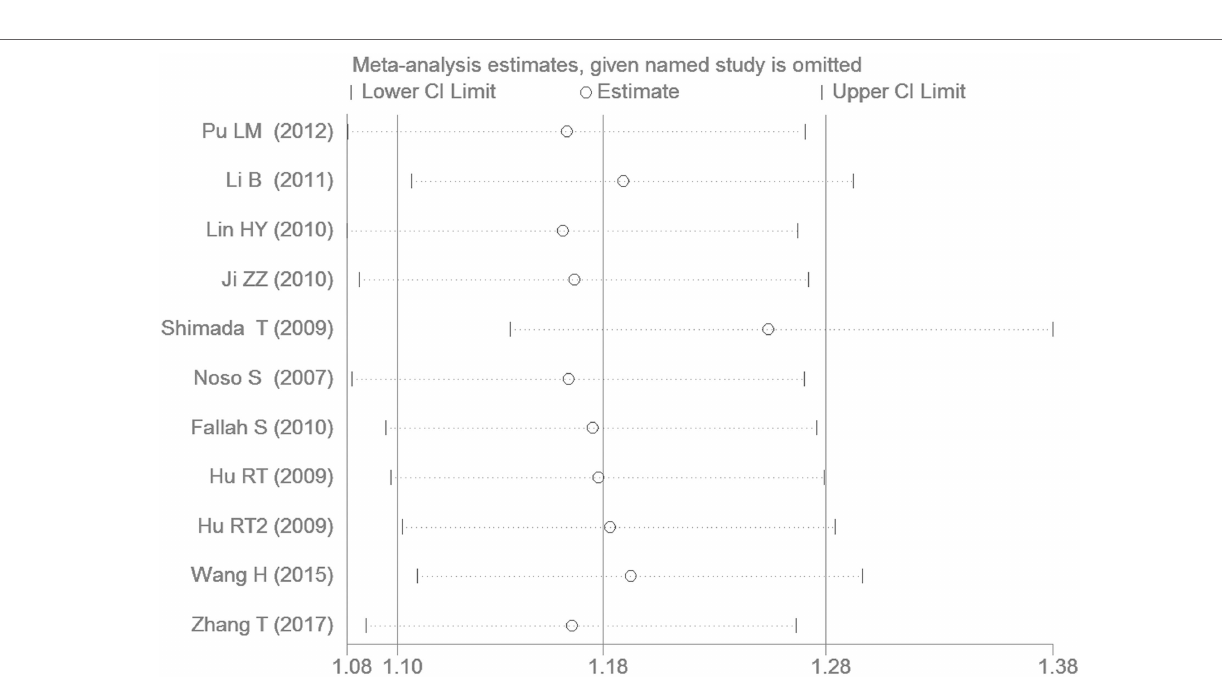
FigUre 9 | The sensitivity analysis results under the additive genetic model (V vs.